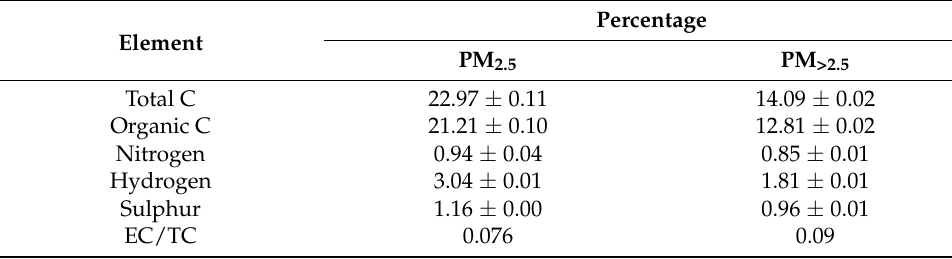
Table 4. Element composition of two aerosols